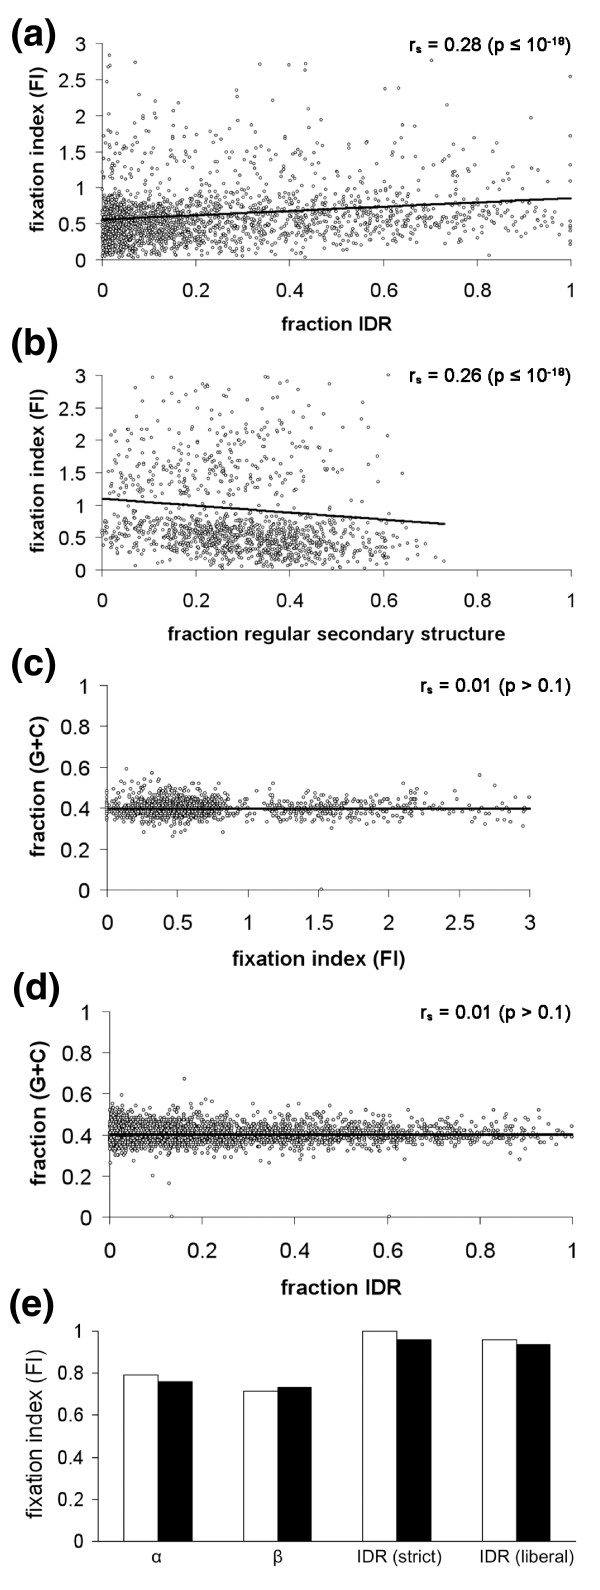
Relative levels of species-specific fixation of variant SNP alleles in each gene are correlated with the level of intrinsically disordered region content in the corresponding proteins. (a, b) Scatter plot showing the fixation index (FI) for genes, calculated by the McDonald-Kreitman test (see Materials and methods), is positively correlated with the fraction of IDR (a) and negatively correlated with the fraction of regular secondary structure (b) in the corresponding proteins. Spearman's rank correlation coefficients (rS) and associated P-values are shown. (c, d) The (G+C) content of genes is not correlated with their FI (c) or with the fraction of IDR in the corresponding proteins (d). Spearman's rank correlation coefficients (rS) and associated P-values are shown. (e) The mean FI corresponding to all IDRs studied is higher than that for all α-helical regions or β-sheet regions studied. The FI for concatenated tracts of predicted α-helical (α), β-sheet (β) and IDRs are plotted. Values are shown for IDR predictions using confidence thresholds of 0.8 (strict) or 0.5 (liberal) (see Materials and methods for details). Open bars designate results obtained for the non-filtered data set while the filled bars designate the data set after removal of outliers (see Materials and methods for details).